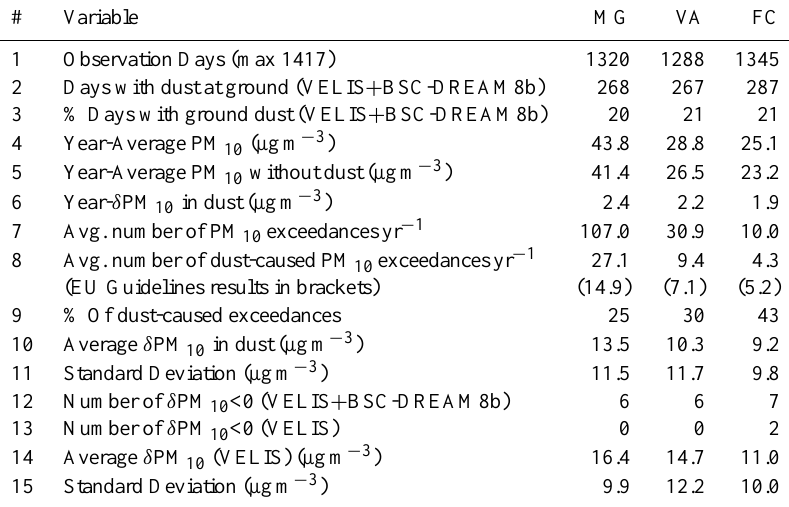
Table 3. Four year statistics (2001–2004) of PM 10 changes observed during dust episodes at the three air quality stations of Magna Grecia (MG), Villa Ada (VA) and Fontechiari (FC). # Variable